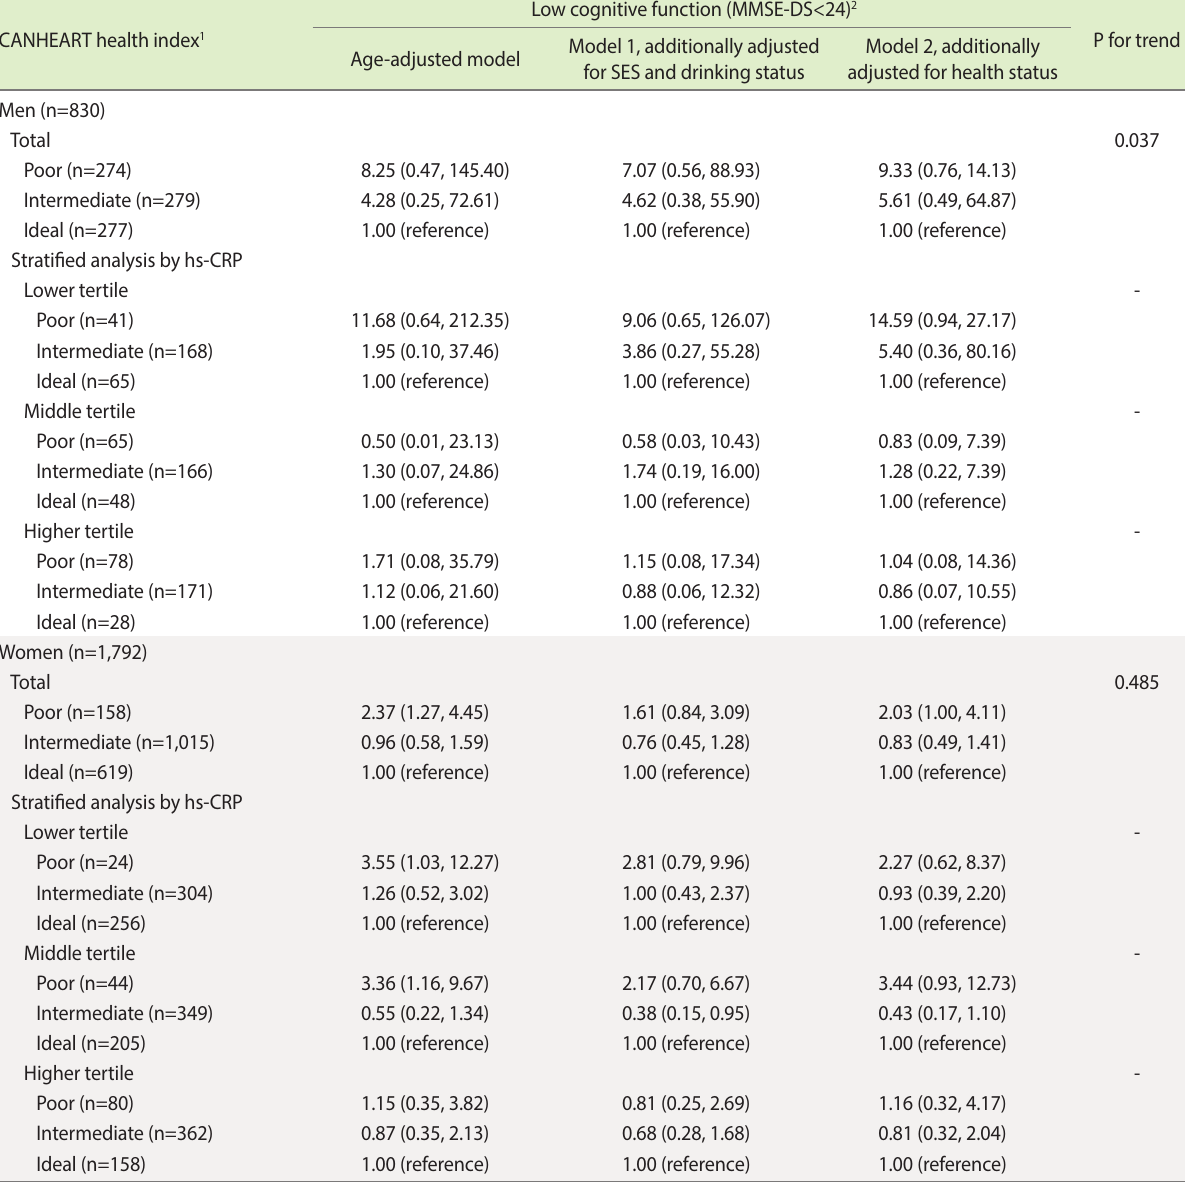
Table 3. Associations between the CANHEART health index and cognitive function in men and women by hs-CRP